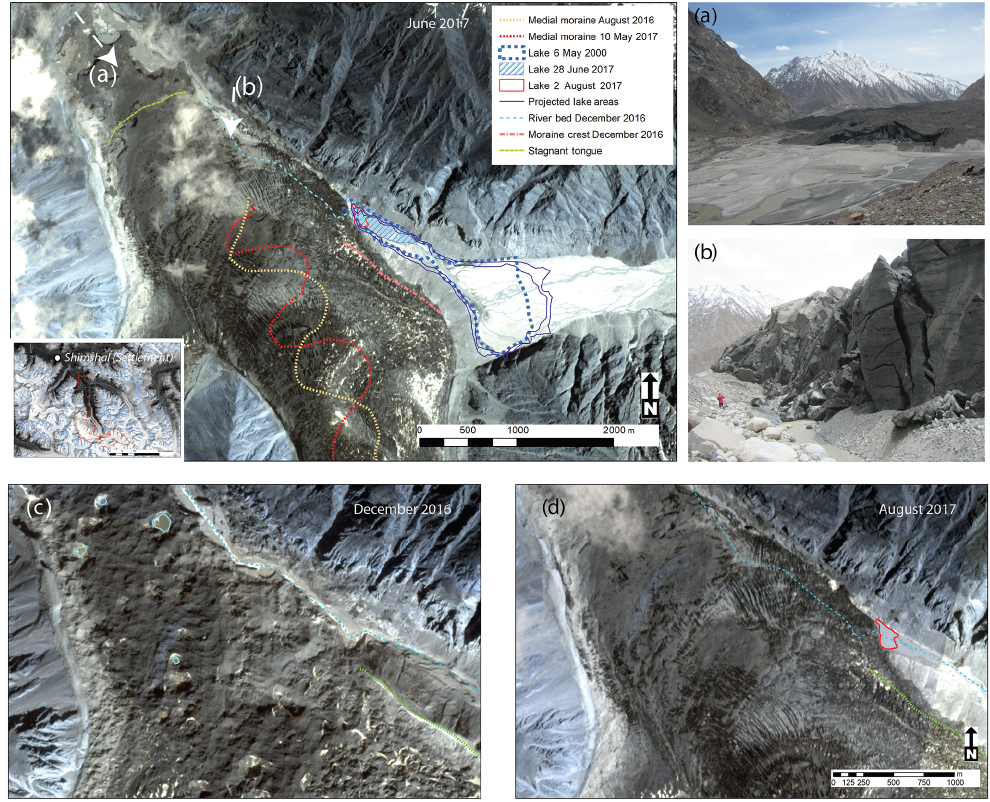
Figure 3. Evidence from the surge event visible at the tongue. The main panel is based on a Planet image from the 28 June 2017 (Planet Team, 2017). The medial moraines, the lake extent in 2017, the original river bed and moraine crest are also mapped from Planet imagery. The lake extent in 2000 is mapped from the panchromatic band of Landsat 7. The projected lake extents and depths are computed based on the TanDEM-X. Arrows at (a) and (b) denote angle of view for images on the right. Panel (a) shows an overview of the front of the tongue and panel (b) shows the front of the advance. Note the fine dark sediments often associated with a surge event. The tongue below the dashed green line showed no change during the surge. Panels (c) and (d) show the tongue surface before and after the surge respectively. (Photos: Waheed Anwar, May